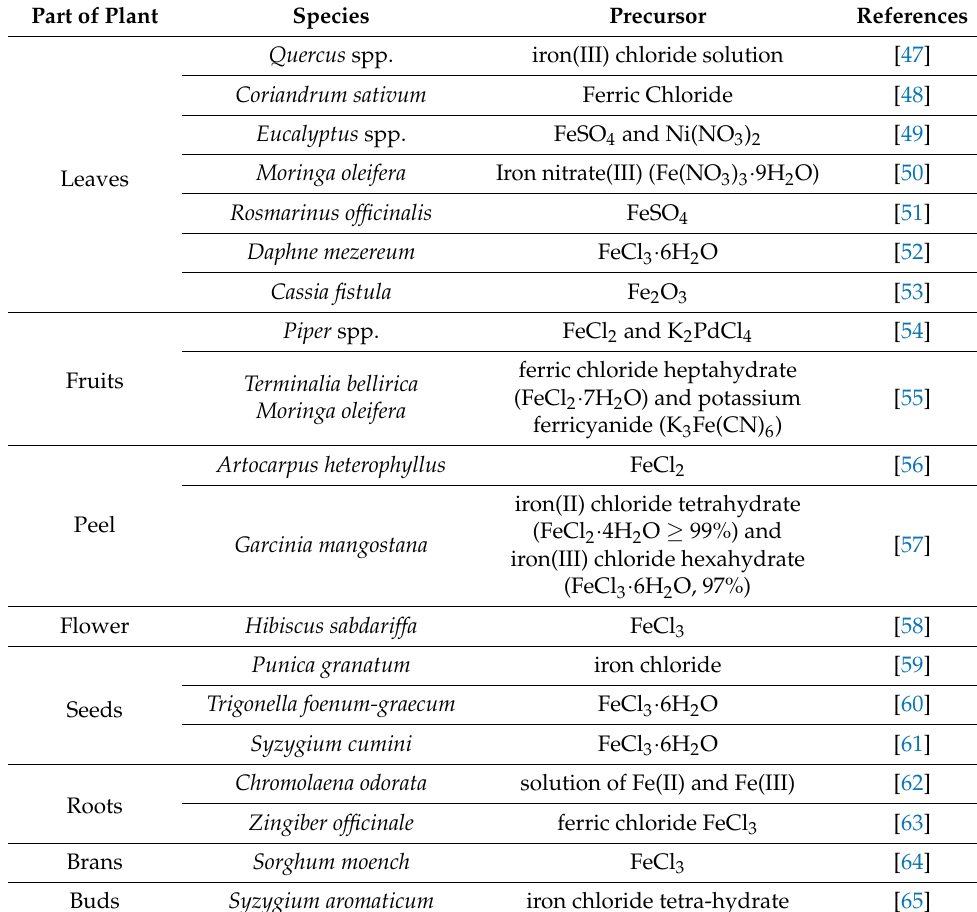
Table 3. Examples of plants used to synthesize iron